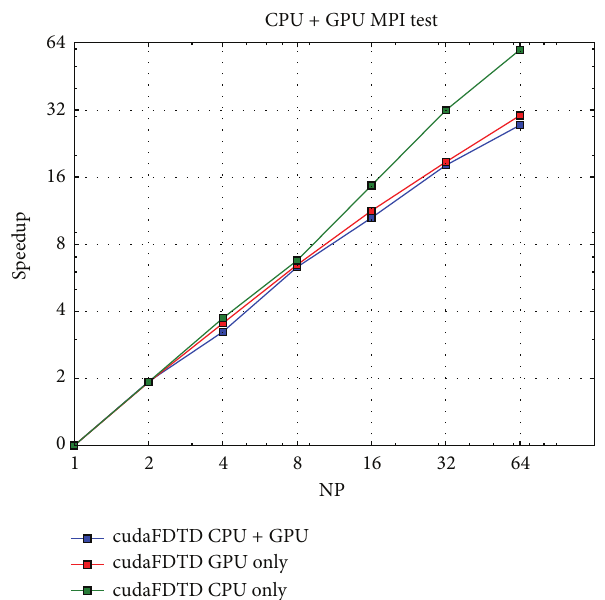
Figure 6: Speedup test of cudaFDTD. The unit of 𝑥 axis is NP (the number of processes) which has different means for different speedup curve: 1 NP = 1 CPU core for pure CPU curve, 1 NP = 1 GPU card for pure GPU curve, and 1 NP = 7 CPU cores + 1 GPU card for CPU + GPU curve. The problem size is 512 × 256 × 256 .